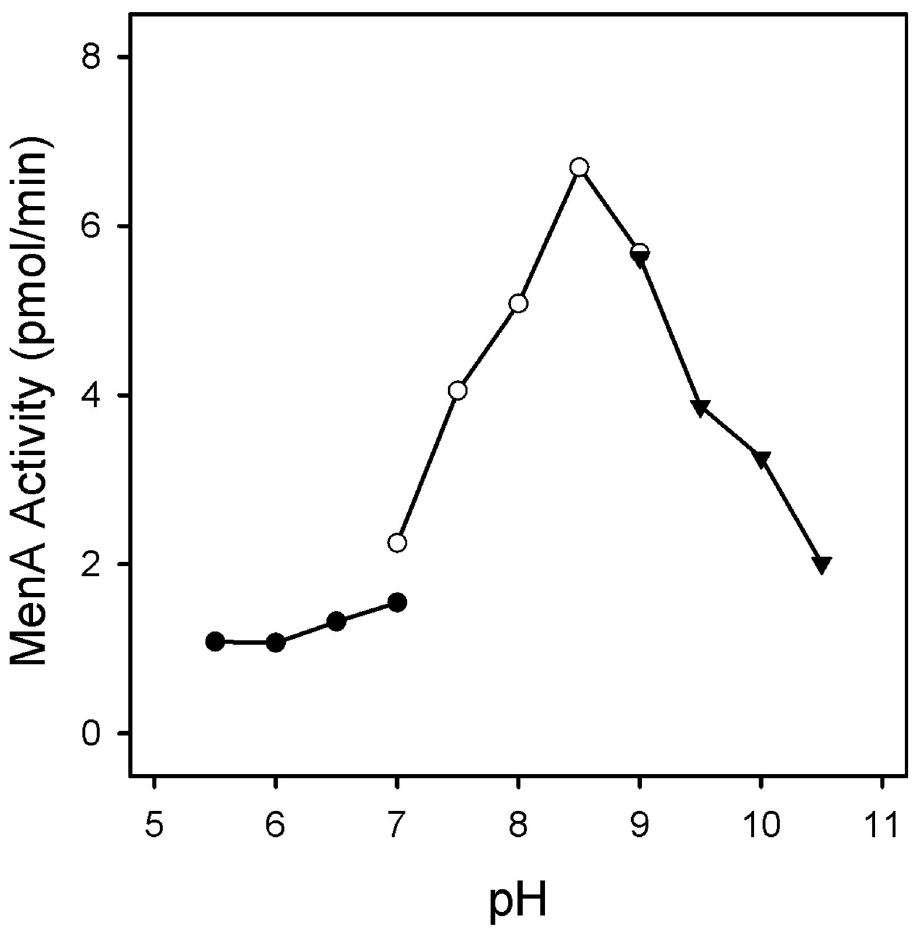
Fig 5. Effect of pH on MenA activity. Reaction mixtures contained 50 mM buffer (at the indicated pH), 5 mM MgCl 2 , 2.5 mM dithiothreitol, 0.1% CHAPS, membrane protein preparation (100 μ g), DHNA (500 μ M) and [1- 3 H]farnesyl diphosphate (10 μ M). Mixtures were incubated at 37˚C for 30 min and processed as described in Materials and Methods section. Three buffers, adjusted to the indicated pH with appropriate counter ions, were used: 50 mM MES (filled circles), 50 mM TAPS (open circles) or 50 mM CAPS (filled